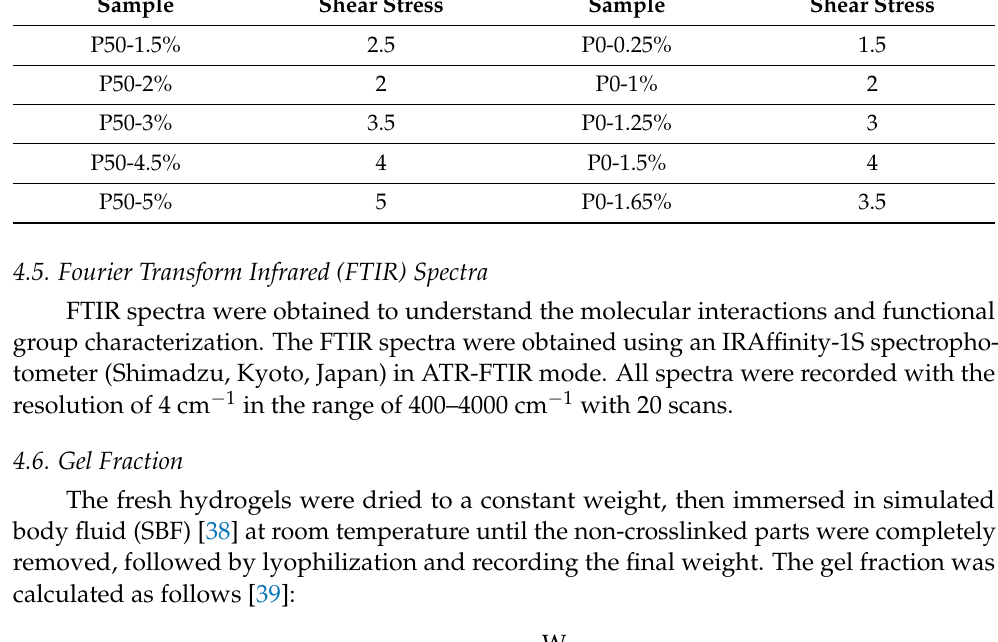
Table 3. Constant shear stress parameter for creep and recovery mode. Sample Shear Stress Sample Shear